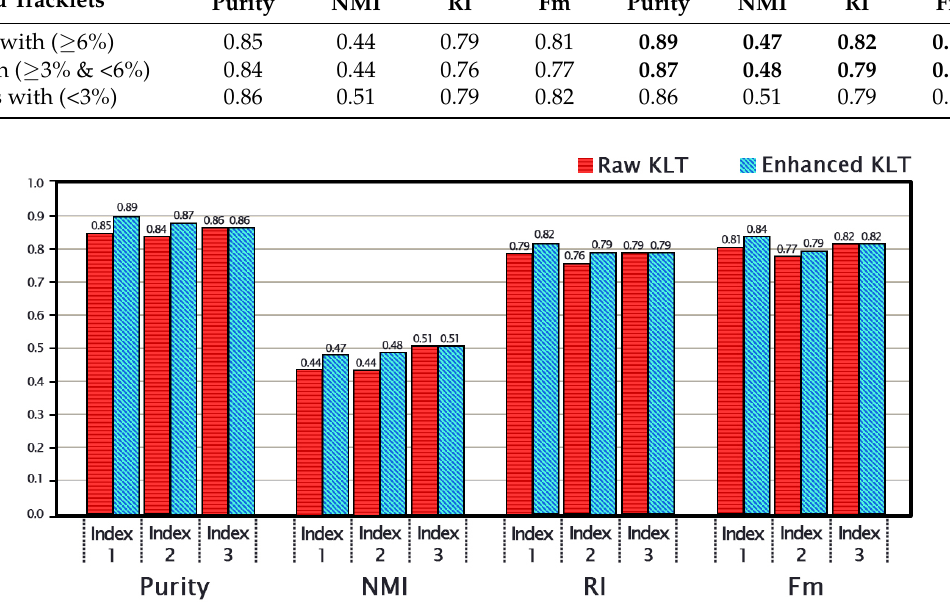
Figure 10. The performance of motion crowd clustering by using the proposed HTA algorithm. The average of the experimental results of Purity, NMI, RI, and F-measure for video clips that have candidate KLT tracklets to be connected equal or higher than 6% (index 1), candidate tracklets to be connected in the range less than 6% and greater or equal 3% (index 2), and candidate tracklets to be connected less than 3% (index 3).